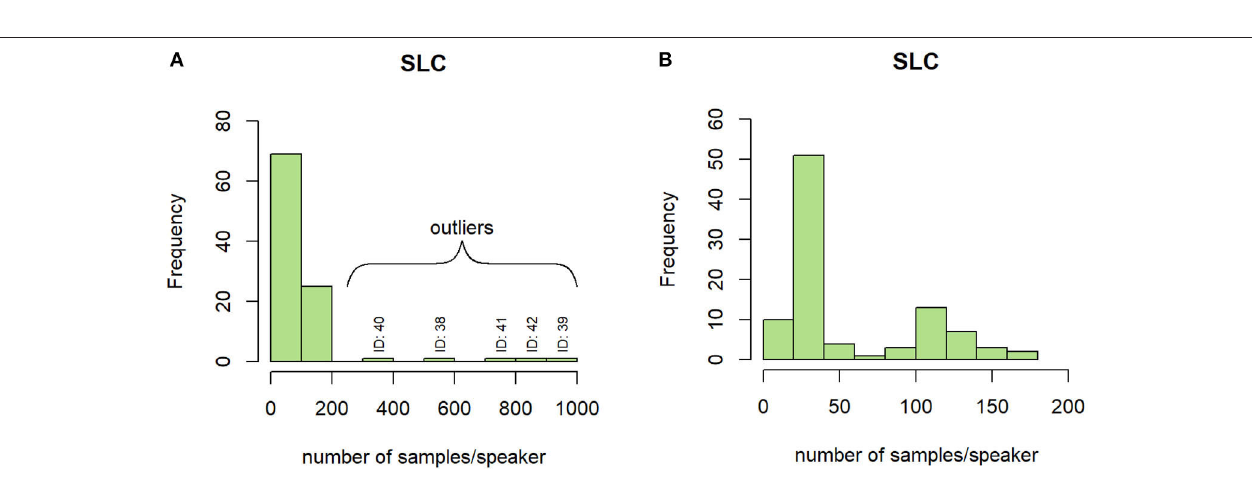
FIGURE 5 | Histogram of the number of samples per speaker on the SLC with (A) and without (B)